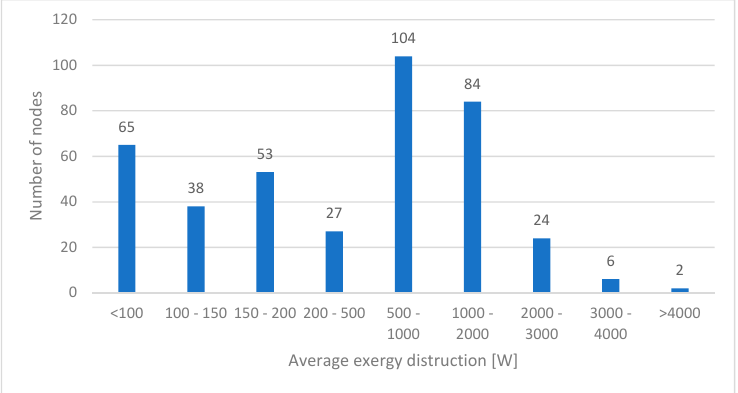
Figure 11. Distribution of exergy destruction in nodes.